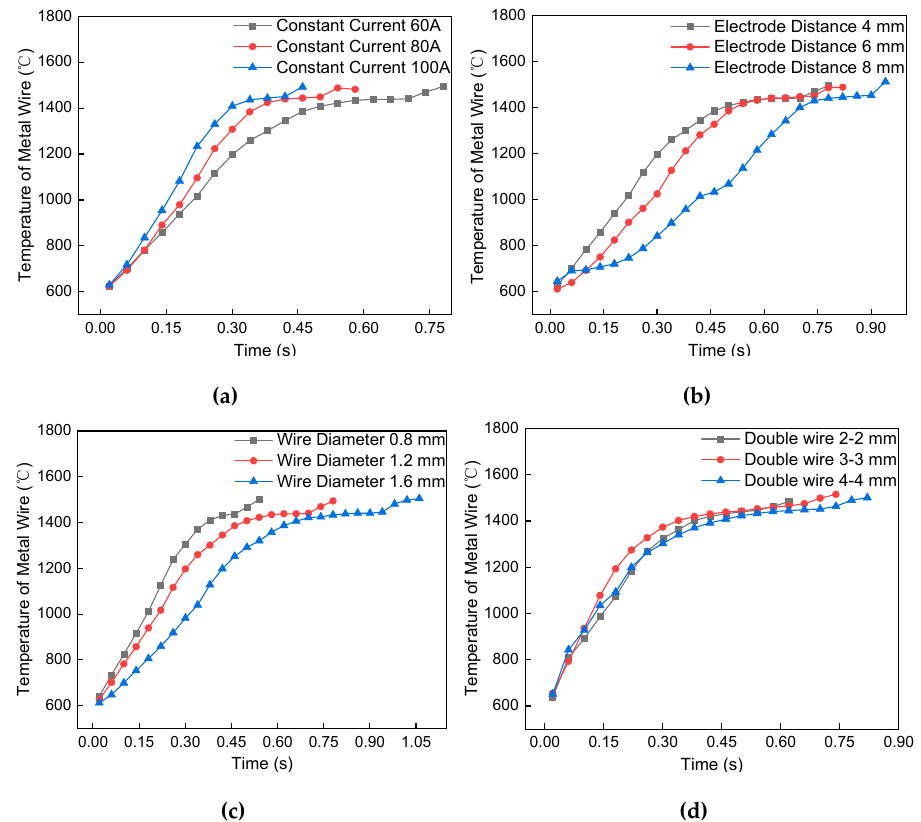
Figure 10. Resistance heating wire temperature trend. (a) Different short-circuit current, (b) electrode distance, (c) metal wire diameter, and (d) double metal wire length.